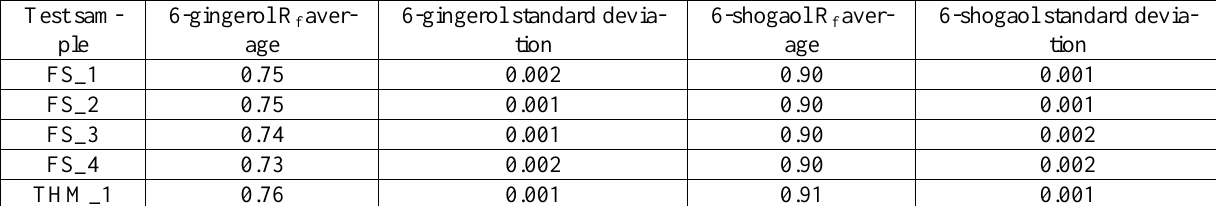
Fig. 1. A - [6]-shogaol standard solution, B – FS_1, C – FD_2, D – FS_3, E – FD_4, F – THM_1, G- [6]-gingerol standard solution.